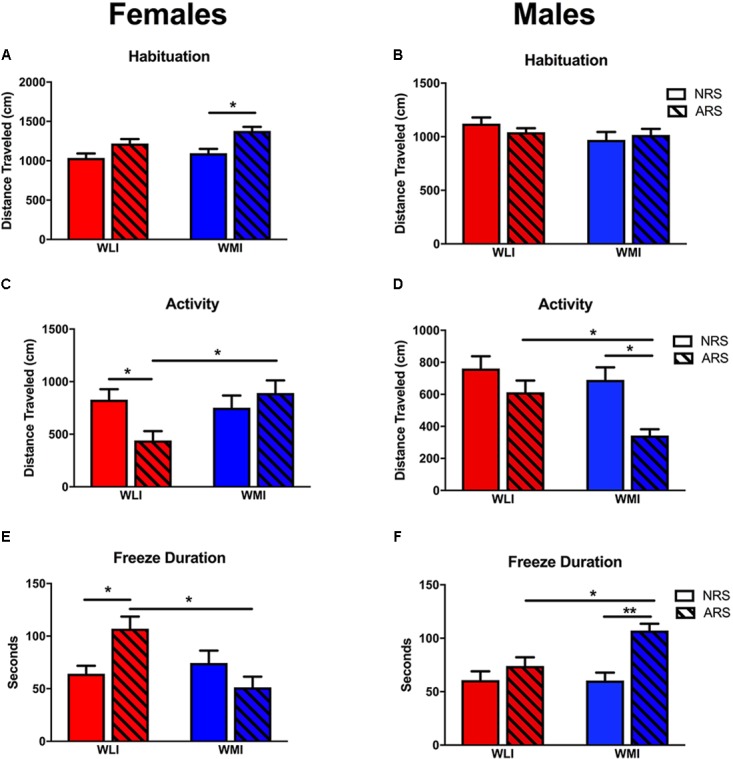
Fear Memory in CFC. Pre-CFC activity, measured by distance traveled in females (A) and males (B). Distance traveled prior to the conditioning stimulus did not differ significantly between strains or acute stress (ARS) and no-stress (NRS) conditions except for WMI females, which showed increased activity after acute restraint stress. Distance traveled on the second day of the contextual fear conditioning did not differ between NRS WLI and WMI females (C) or NRS males (D). However, WLI females and WMI males showed significantly decreased distance traveled after ARS. Showing the inverse relationship, WLI females and WMI males showed significantly increased freeze duration after ARS, with no differences in fear duration between the strains in the NRS condition (E,F). Values are shown as mean ± SEM; ∗p < 0.05, ∗∗p < 0.01, post-hoc following ANOVA. WLI NRS male n = 26; NRS female n = 23; AS male n = 17, AS female n = 13; WMI NRS male n = 15, NRS female n = 18, AS male n = 15, AS female n = 10.